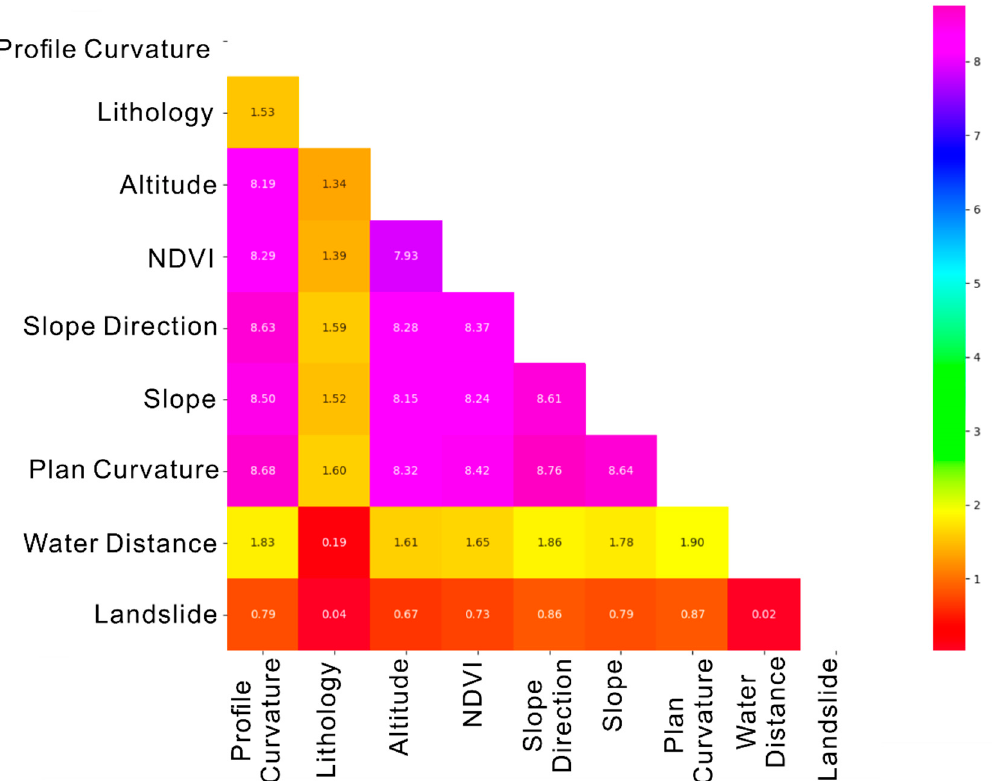
Figure 7. Environmental factor mutual information.